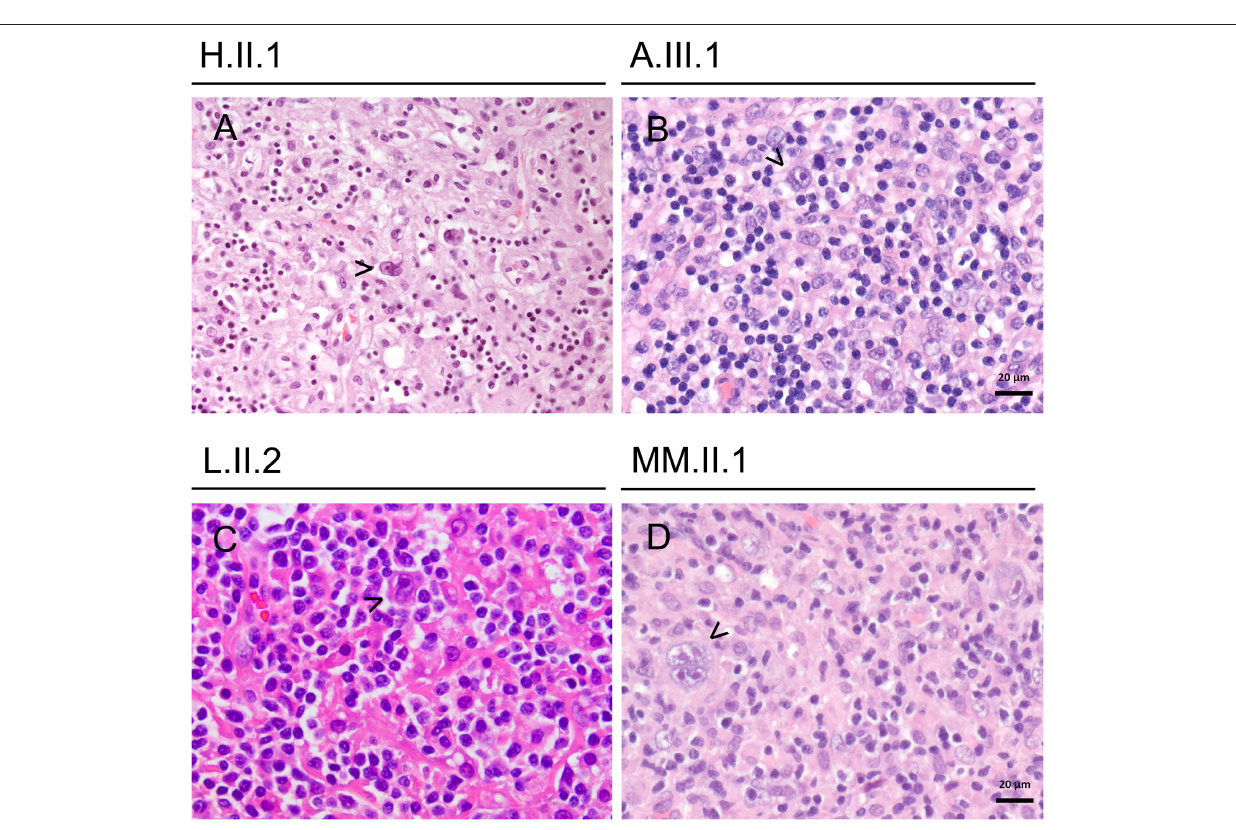
pancolitis, at the age of 16 years. The diagnosis of lymphocyte- rich Hodgkin lymphoma was established based on an inguinal lymph node